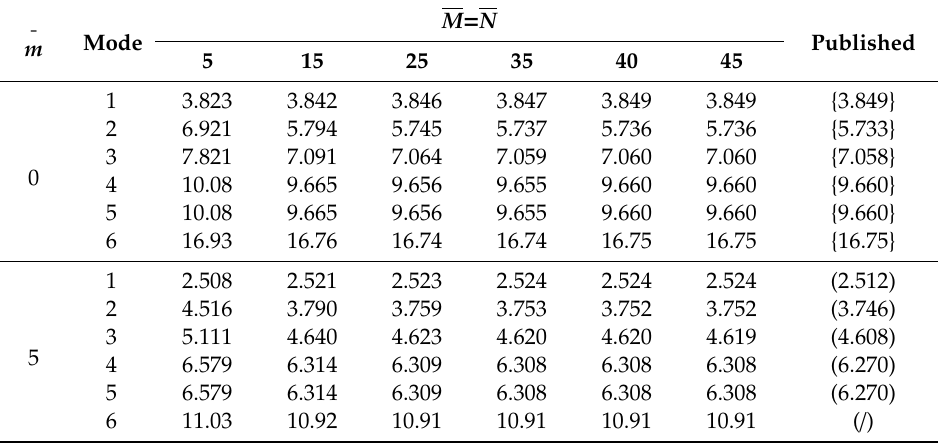
Table 5. Convergence of Ω for FFFF FGM square plates with h / b =